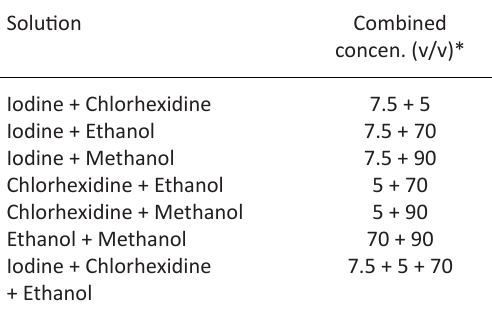
Table 2. combination of sterilizing agents